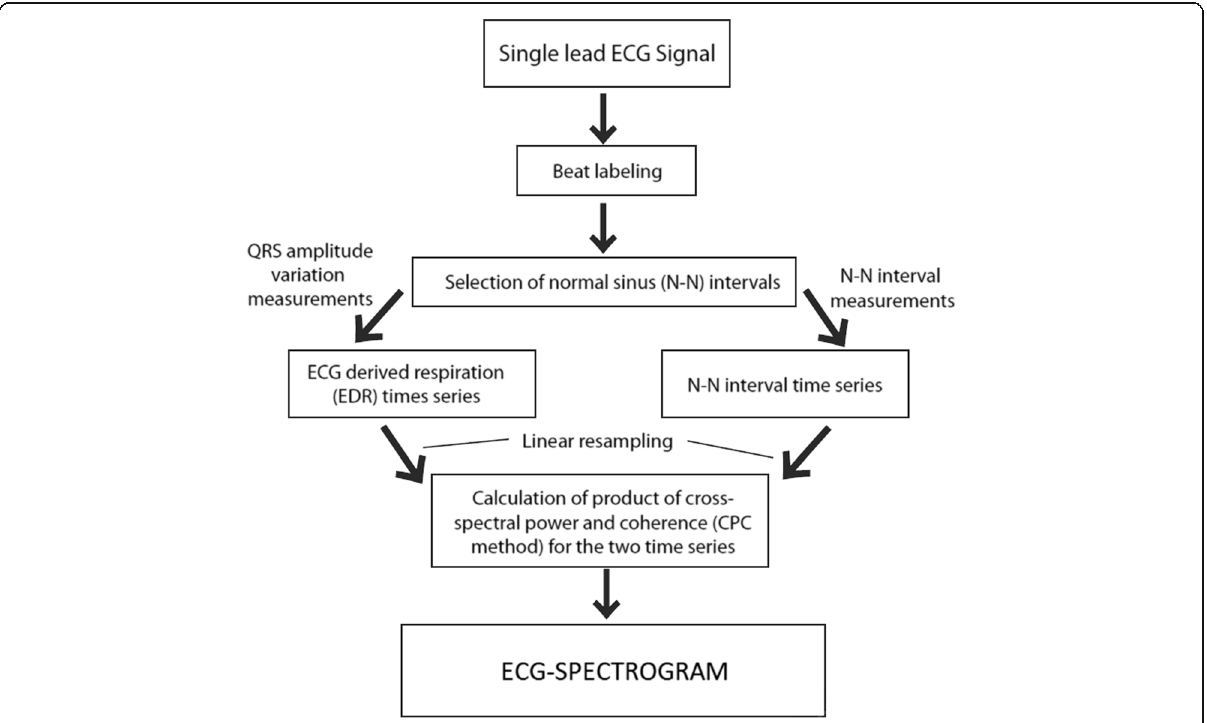
Fig. 1 Algorithm outline for the ECG-cardiopulmonary coupling analysis. The schema describes the analytic pathway for cardiopulmonary coupling analysis, using two distinct data streams embedded within the ECG: autonomic drive via heart rate variability and respiratory ECG-R amplitude modulation as a surrogate of